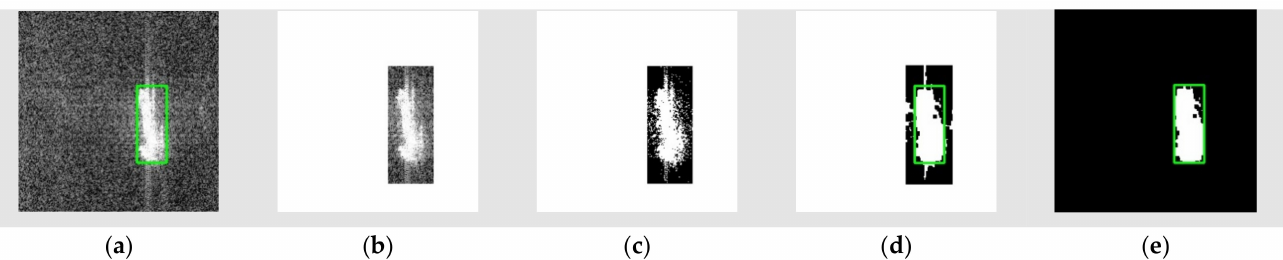
Figure 3. Processing rendering of mask extraction strategy; the green box is the label. ( a ) Original image. ( b ) Image slice. ( c ) Binary image after thresholding. ( d ) Binary image after morphology processing. ( e ) Final